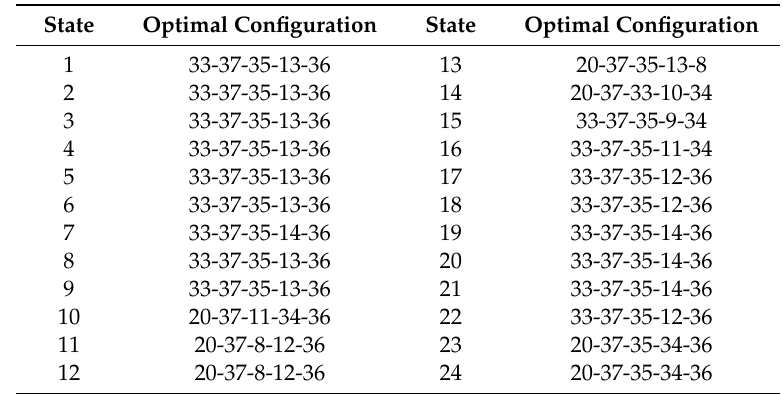
Table 8. Optimal configurations obtained after NR.